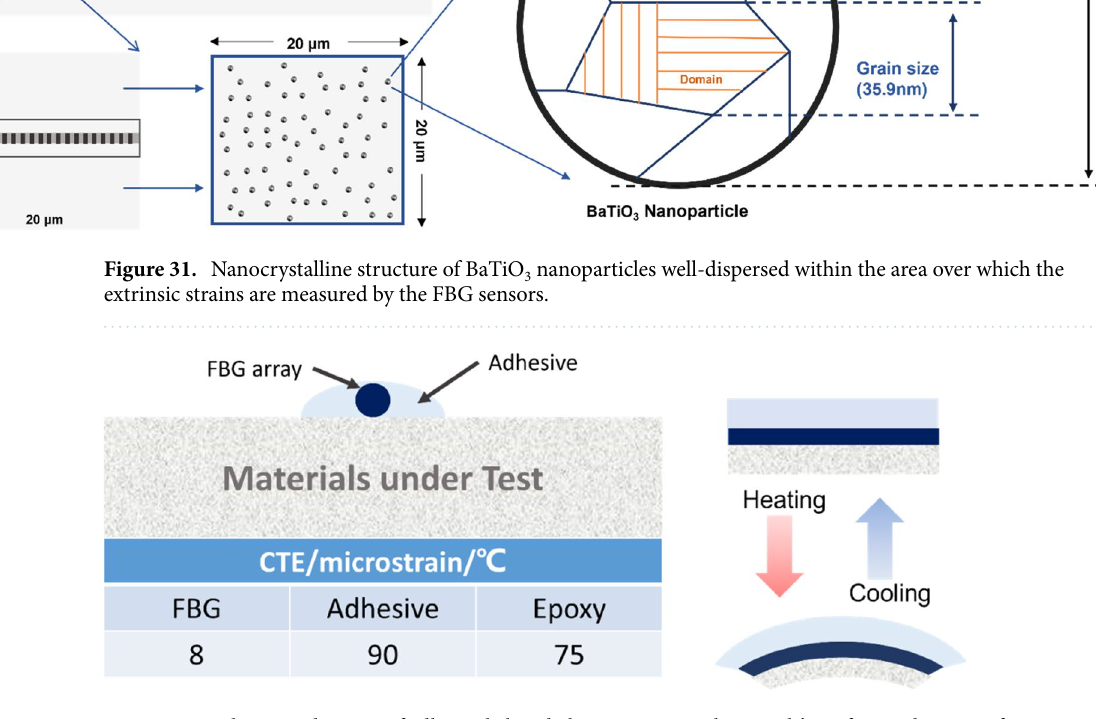
Figure 32. Schematic diagram of adhesively bonded FBG arrays to the sample’s surface and non-uniform thermal expansion due to mismatch in